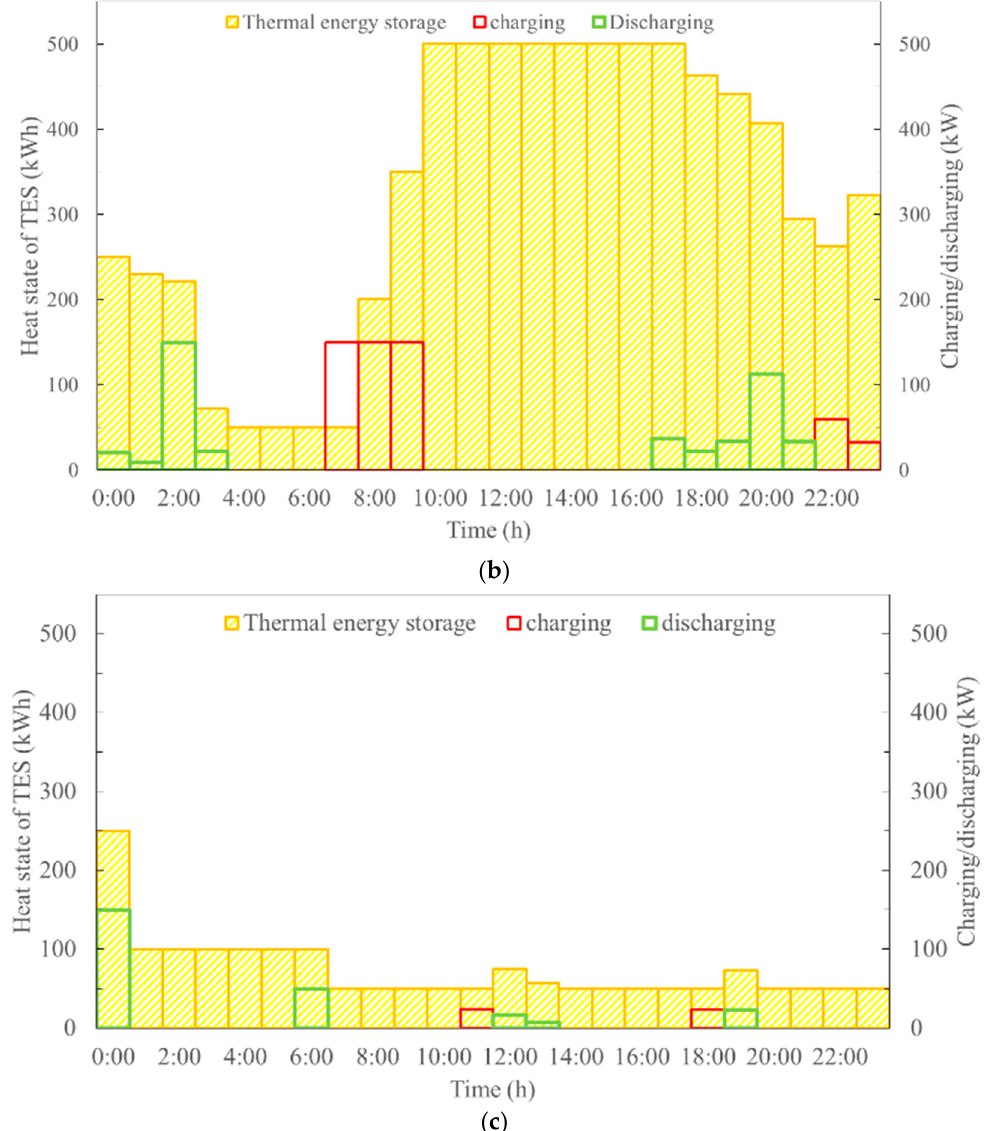
Figure 9. The hourly energy flow of thermal energy storage in different season: ( a ) transition season; ( b ) summer; ( c ) winter.